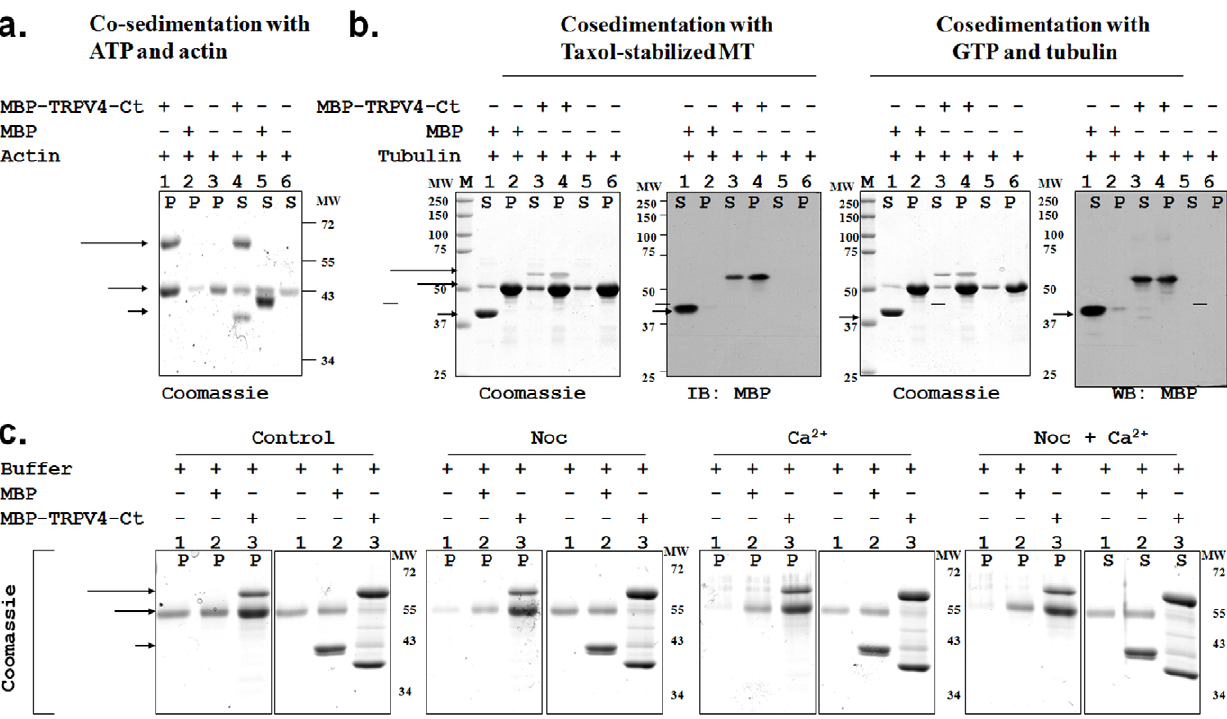
Figure 2. TRPV4 interacts directly with polymerized actin and microtubule filaments. MBP and MBP-TRPV4-Ct were centrifuged at 70000 g/30 min/4 u C and only soluble proteins present in the supernatant were used for all co-sedimentation experiments. a. MBP-TRPV4-Ct co- sediments with polymerized actin filaments. Actin was polymerized either in presence of MBP-TRPV4-Ct (lane 1 and 4), in presence of MBP only (lane 2 and 5) or in buffer only (lane 3 and 6). Polymerized actin filaments and associated proteins were isolated from remaining soluble actin and unbound proteins by centrifugal separation of pellets ( P , lane 1–3) from corresponding supernatants ( S , lane 4–6). The entire amount of MBP remains in the supernatant (lane 5) while a significant amount of MBP-TRPV4-Ct appears in the pellet (lane 1). Arrows indicate the position of respective proteins. b. MBP-TRPV4-Ct co-sediments with microtubules. Taxol-stabilized microtubules (left panel) were incubated with MBP (lane 1–2), MBP-TRPV4-Ct (lane 3– 4) or with buffer only (lane 5–6) followed by the centrifugal separation of pellet ( P ) consisting MT and bound proteins from supernatant ( S ) consisting of soluble tubulin and other unbound proteins (left side panel). In right side panel, soluble tubulin and GTP was incubated with MBP (lane 1–2), MBP- TRPV4-Ct (lane 3–4) or buffer only (lane 5–6) followed by separation of pellet ( P ) and supernatant ( S ). Note the specific presence of MBP-TRPV4-Ct in the pellet in both cases (in lane 4). c. MBP-TRPV4-Ct stabilizes microtubules against depolymerizing factors. Microtubules was formed form soluble tubulin in buffer (lane 1), along with MBP (lane 2) or along with MBP-TRPV4-Ct (lane 3) in control condition (left most panel), in presence of Nocodazole (middle left panel), in presence of Ca 2 + (middle right side) or in presence of both Nocodazole and Ca 2 + (right most). Microtubules and bound proteins present in the pellet fraction ( P ) were isolated from unpolymerized tubulin and unbound proteins remaining in the supernatant ( S ) by centrifugal separation. Note the enhancement of polymerized microtubules (represented by tubulin present in lane 3, P fraction in every conditions) due to the presence of MBP-TRPV4-Ct.